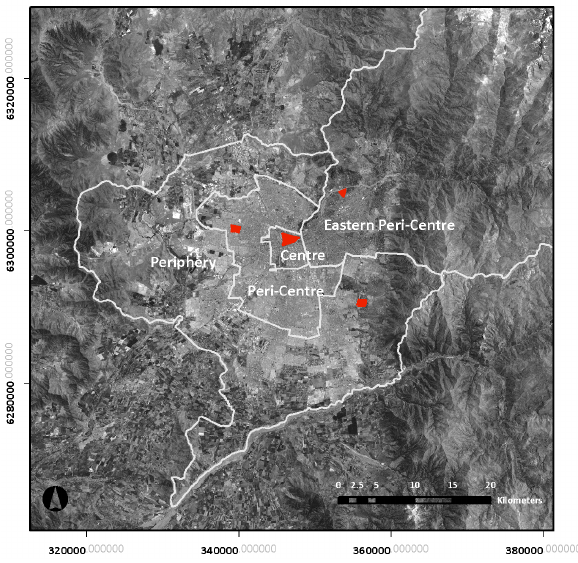
Höfer et al., 2009)